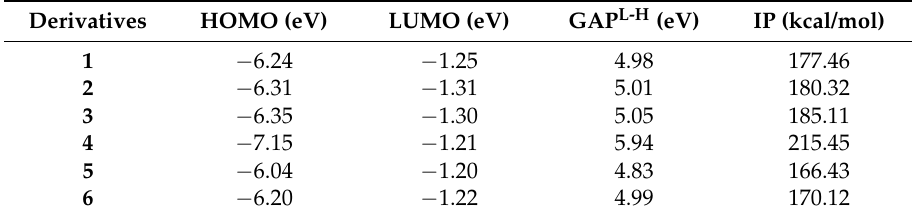
Table 1. Theoretical properties of phenylbutazone derivatives.